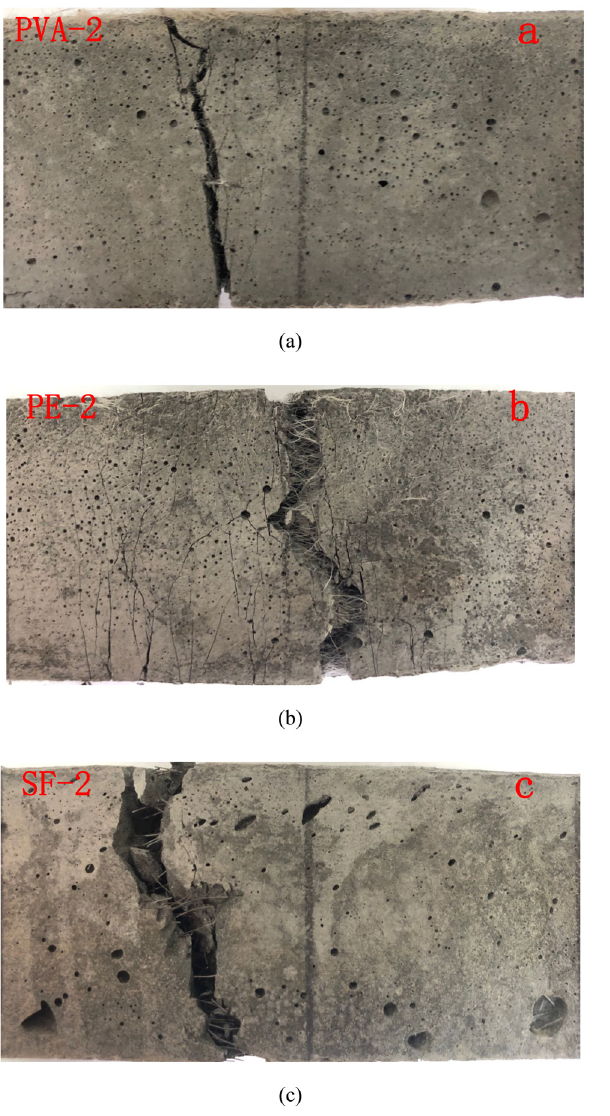
Figure 10: The fl exural failure morphology of lightweight cement - based composites: ( a ) PVA - 2, ( b ) PE - 2, and ( c ) SF - 2.